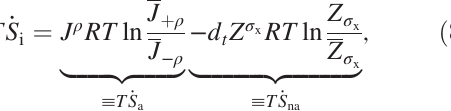
FIG. 4. Pictorial representation of the transformation between two nonequilibrium concentration distributions. The nonequili- brium transformation (blue line) is compared with the equilib- rium one (green line). The equilibrium transformation depends on the equilibrium states corresponding to the initial and final concentration distributions. In Sec. III E 3, for an arbitrary CRN, these equilibrium states are obtained by first closing the network and then letting it relax to equilibrium. Instead, in Sec. V, for a detailed balance CRN, the equilibrium states are obtained by simply stopping the time-dependent driving and letting the system spontaneously relax to